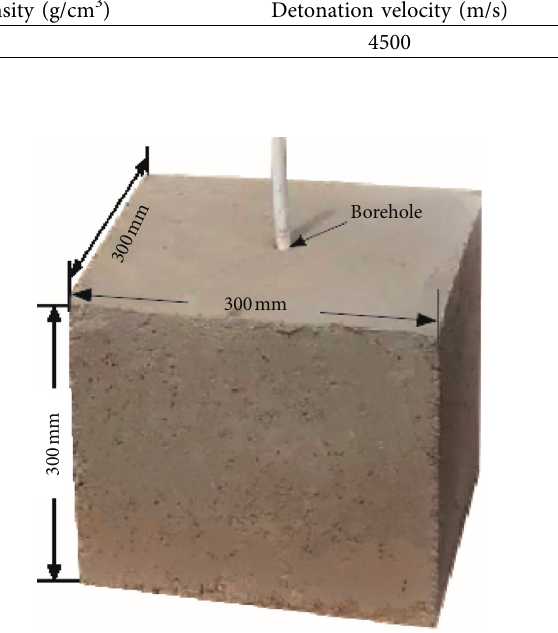
Figure 3: Concrete model specimen.